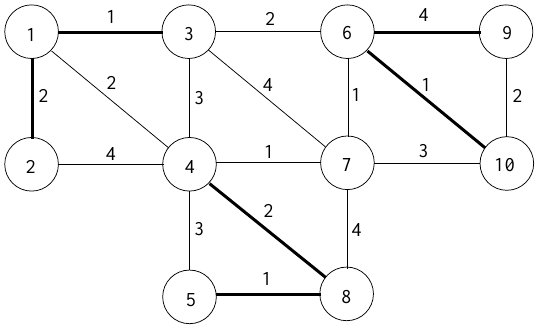
Figure 5: An example RPP problem instance. Edge cost weights are shown next to each edge, and required edges are denoted in bold